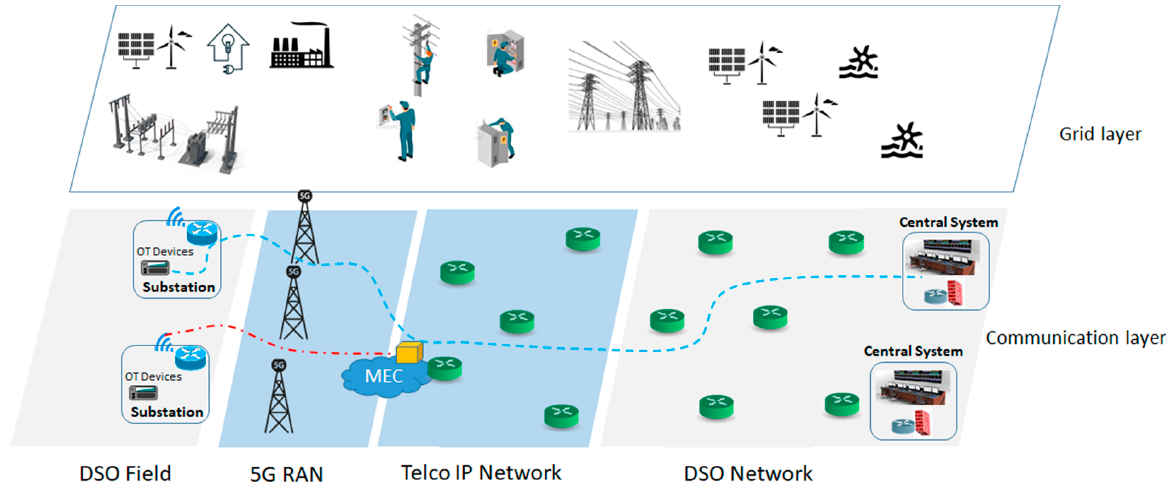
Figure 8. Site architecture of UC1.